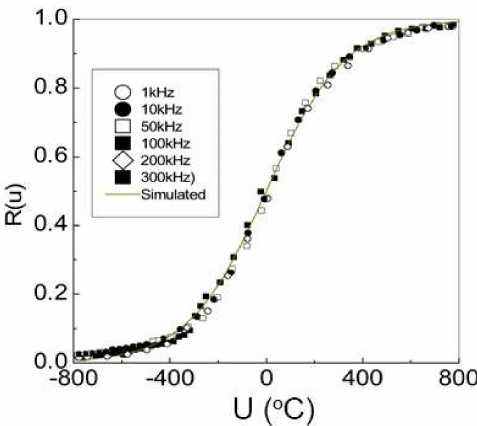
Figure 7. The scaling function R(u) versus the scaling variable u at various frequencies for the reentrant relaxor FE phase.